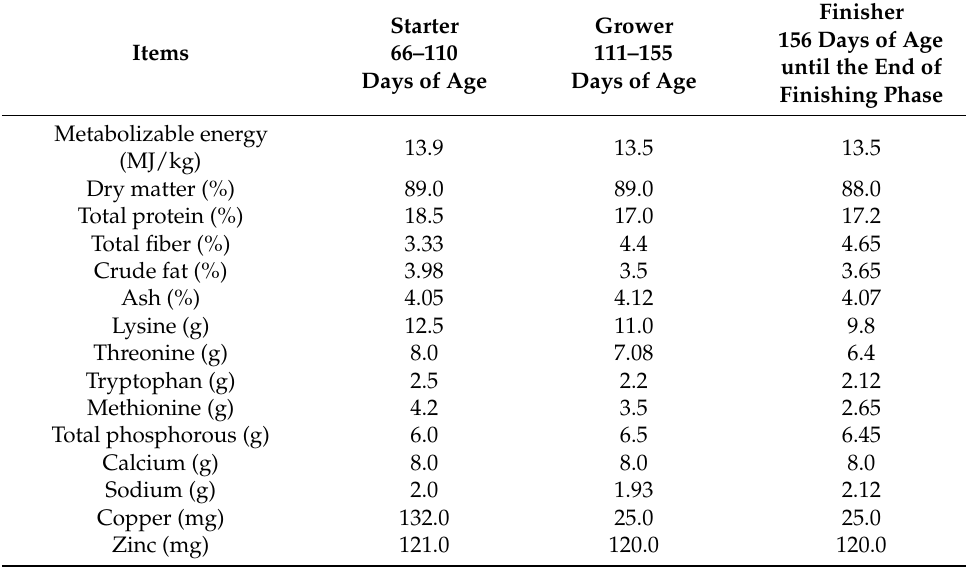
Table 1. Chemical composition of basal